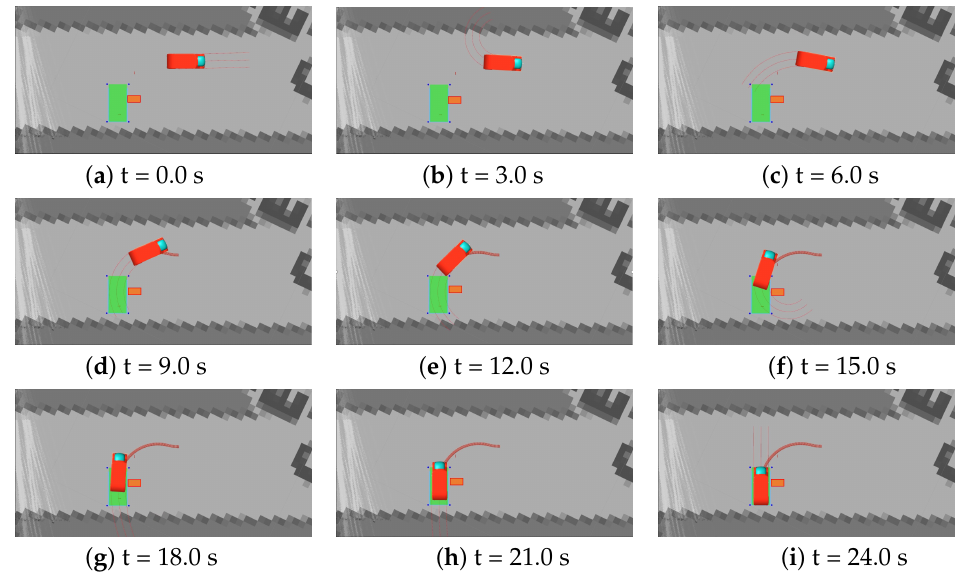
Figure 12. Vehicle parking w.r.t freight at different time